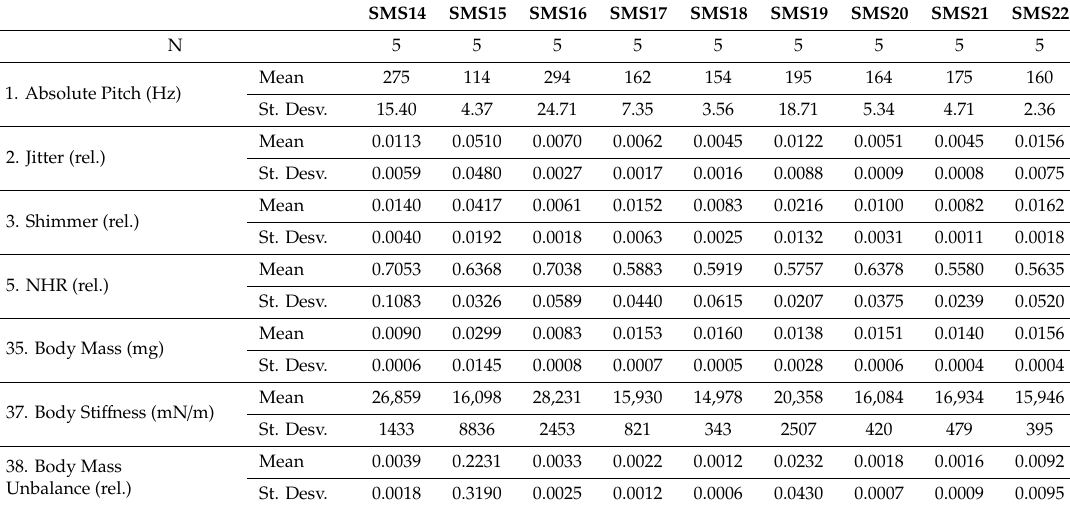
Table 4. Average of the 5 voices of the 9